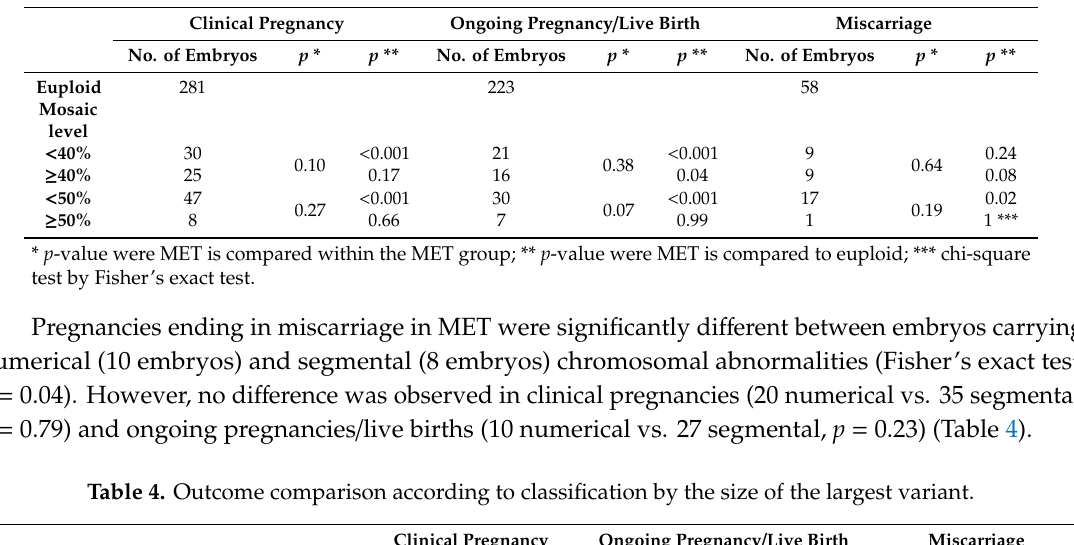
Table 4. Outcome comparison according to classification by the size of the largest variant. Clinical Pregnancy Ongoing Pregnancy / Live Birth Miscarriage Classification by Size of Mosaic Variant * MET p -Value MET p -Value MET p -Value Numerical 20 10 10 0.79 0.23 0.04 Segmental 35 27